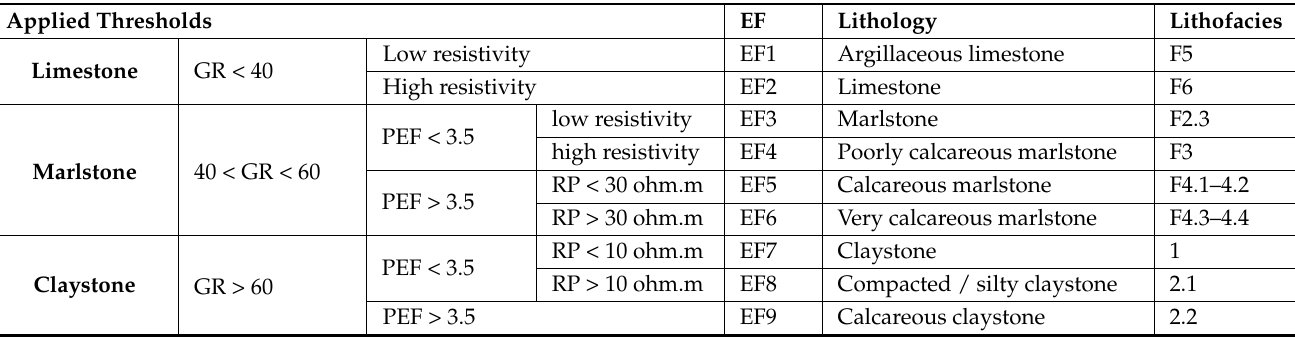
Figure 5. Diagrams in 3D showing the relationship between the wirelines’ signals (x and y axes) and lithofacies descriptions (plotted by colour). The DT (Sonic) and density values are well correlated and show redundant information with the GR and PEF values. The most discriminant wirelines for lithofacies determination are GR, DR and PEF. Table 2. Correspondence between lithofacies and